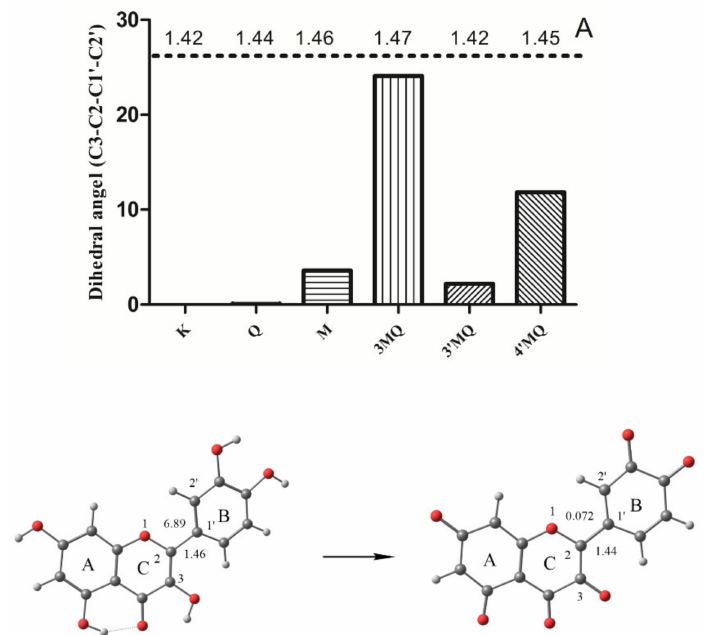
Figure 4. The dihedral angle (C3–C2–C1 (cid:48) –C2 (cid:48) ) of tested compounds and the optimized structure of